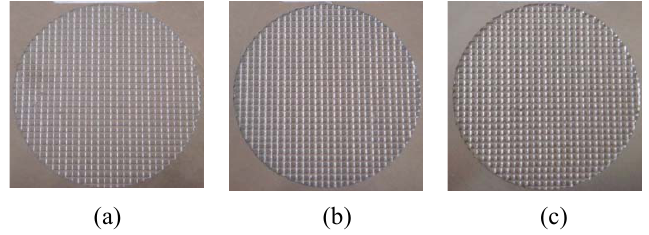
Fig. 4. Photo of rough surfaces on test block: (a) S1, R